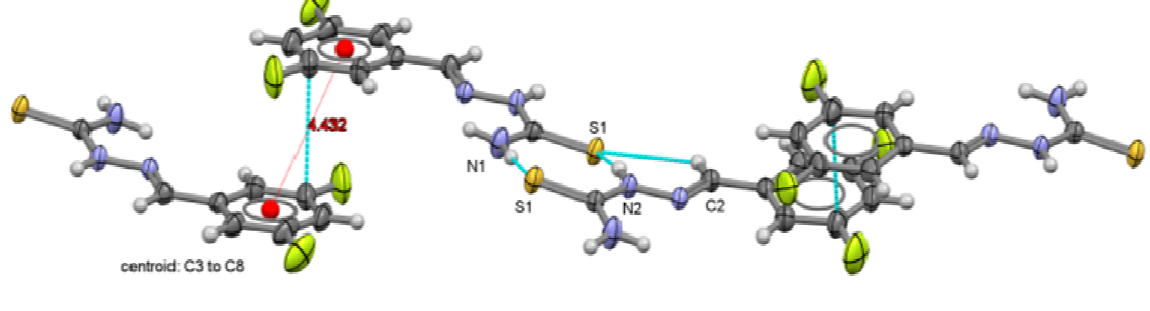
Figure 11. Packing arrangement of 3,5-C interactions between thiophenolate